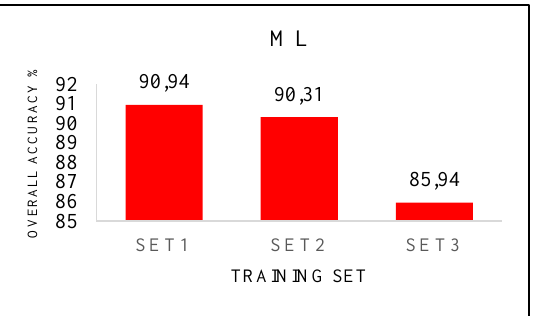
Figure 2. ML classification and training set